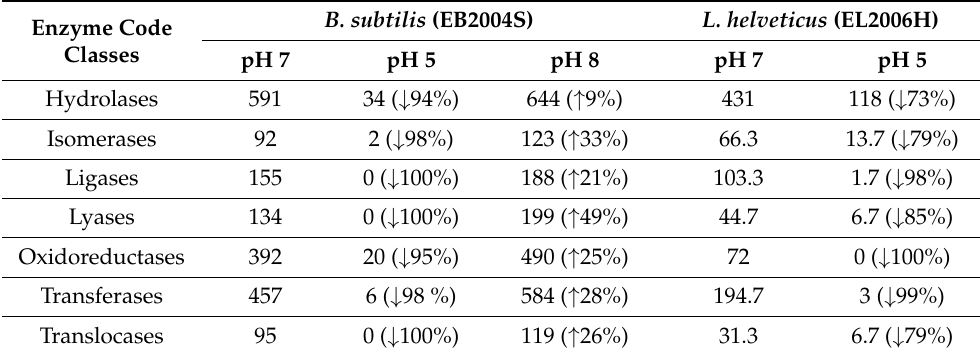
Table 2. Differences in the enzyme code distribution of B. subtilis (EB2004S) and L. helveticus (EL2006H) CFS in comparison with the reference pH 7. The percentages in the parenthesis indicate increases ( ↑ ) and decreases ( ↓ ) in the expression of a given enzyme compared to the reference pH